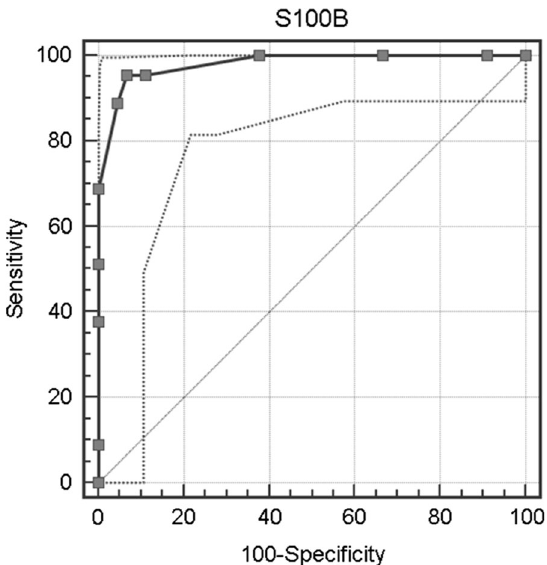
Fig. 1 The receiver operating curve (ROC) analysis of S-100B